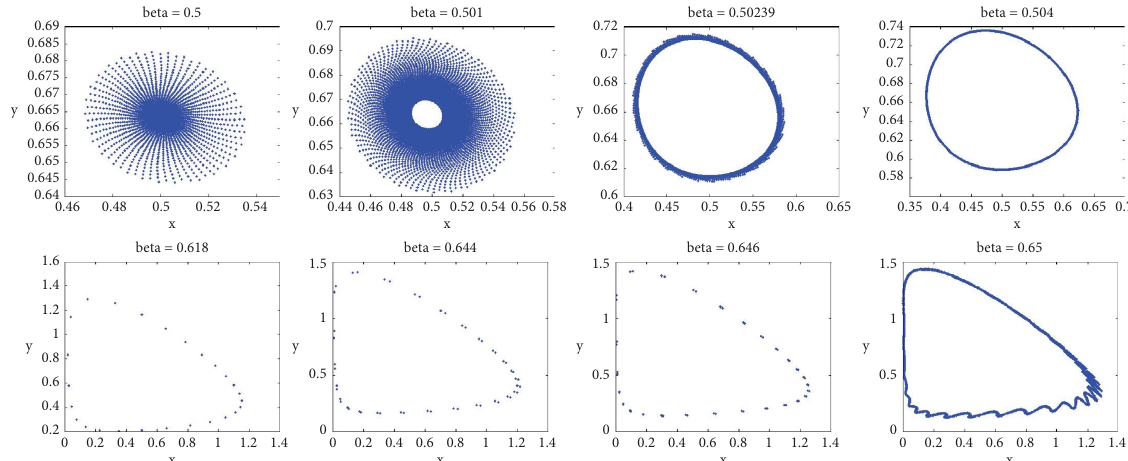
Figure 7: Phase portraits (in xy -plane) associated with Figures 6(a) and 6(b).